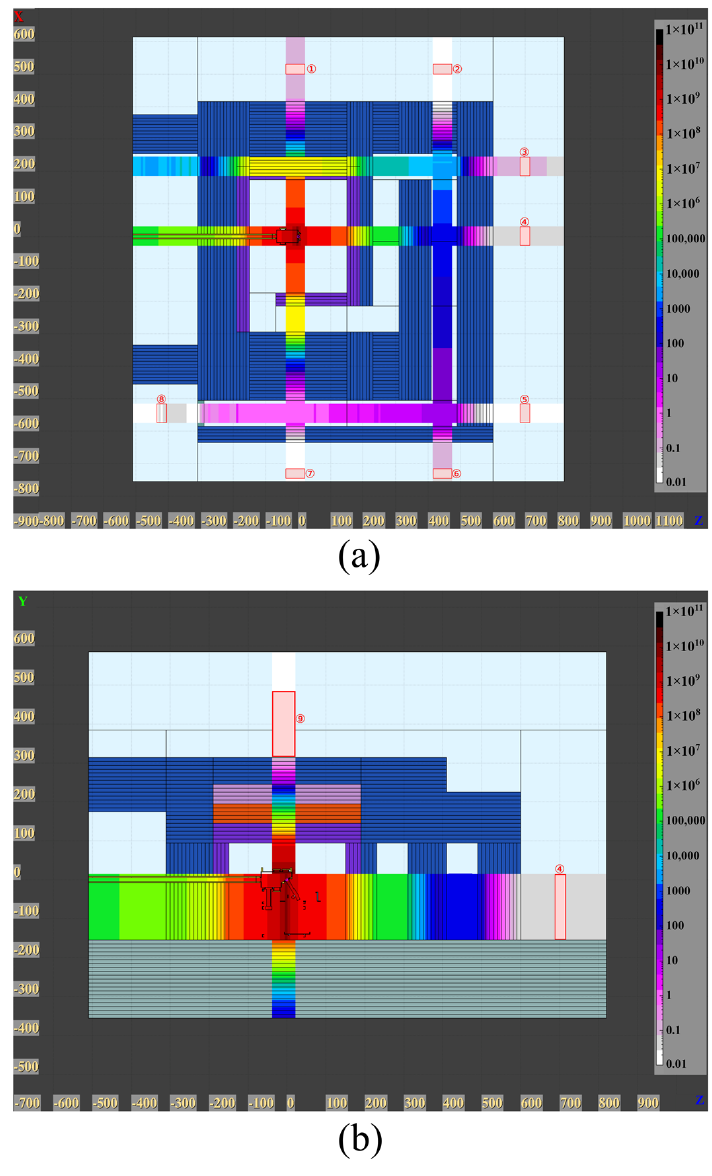
Figure 12. Location and ambient dose equivalent rate distributions ( µ Sv/h) in the regions of interest. ( a ) Top view at beamline level, ( b ) Side view at beamline level. The materials are indicated by different colors corresponding to Figure 4. Distances are given in cm.